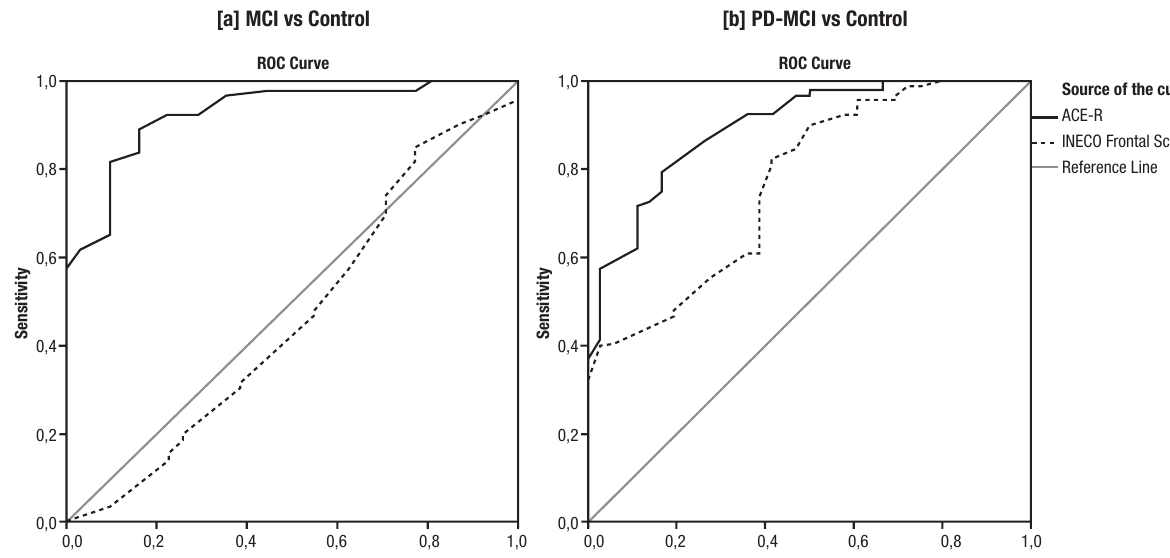
Figure 1. ROC curves of ACE-R (total score) and INECO Frontal Screening (total score) for detecting [a] MCI and [b]